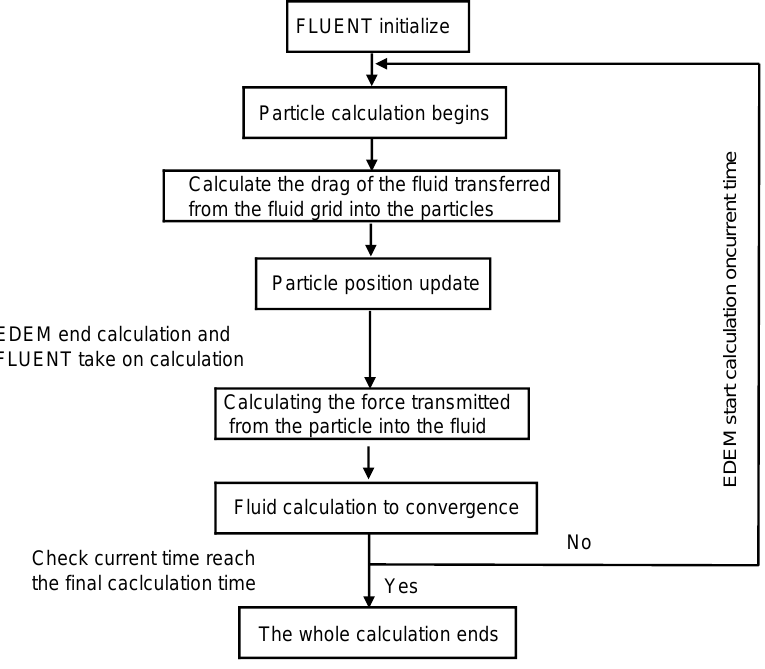
Figure 2. Coupled simulation flow chart.